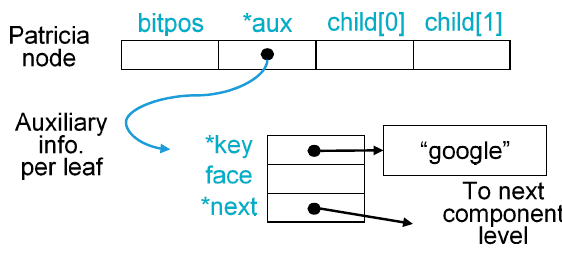
Figure 7. Patricia node and auxiliary information.